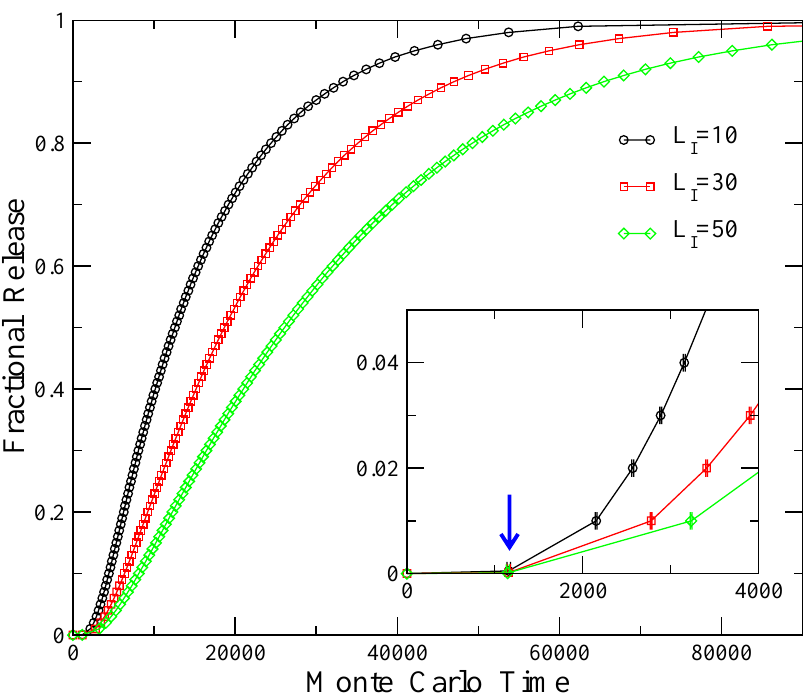
Figure 2. Fractional release profiles for slabs with outer layer thickness L O = 30, diffusivity D O = 0.2, and inner layer thicknesses L I = 10 (black circles), 30 (red squares), and 50 (green diamonds). Other parameters are L x = L y = 20 and C 0 = 0.5. The inset shows a magnification of the plot in the beginning of the release, at small times. The arrow indicates the lag time, obtained by the first non-zero point of the release curve (see text). Error bars in the x-axis of the inset represent mean-value errors (not shown in the main plot, for clarity) calculated through 100 different Monte Carlo realizations. Lines are guides to the eye.